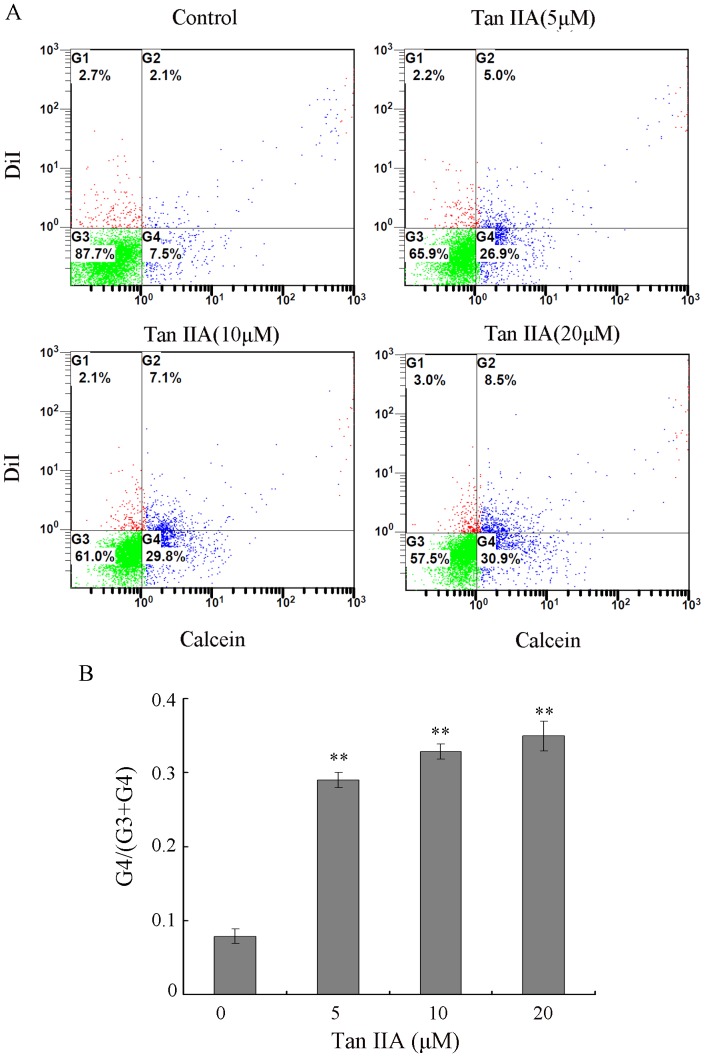
Tan IIA promotes GJIC of B16 cells, as measured by fluorescent dye transfer.B16 cells were left untreated (control) or treated with Tan IIA (5, 10 or 20 µM) for 18 h. Donor cells were pre-loaded with two fluorescent dyes: DiI and Calcein AM. A 1∶100 mixture of labeled donor cells and unlabeled recipient cells was co-cultured for 6 h in the presence of Tan IIA followed by flow cytometry analysis. (A) Flow cytometric analysis for fluorescent dye transfer.G1: Cell populations positive for DiI; G2: Cell populations positive for both DiI and Calcein; G3: Double negative cells; G4: Cell populations positive for Calcein only. (B) Quantification of three independent experiments. The G4/(G3+G4) of experimental groups was higher than that of the control, indicating more efficient cell-to-cell spread of Calcein after Tan IIA treatment. **p<0.01 compared with control.